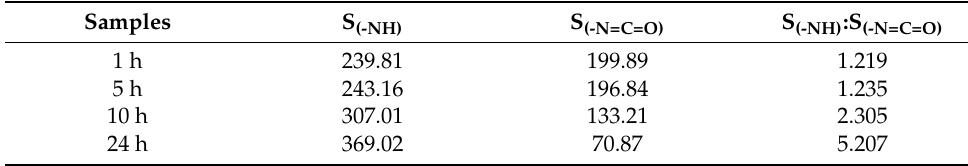
Figure 7. FT-IR spectra of emulsion with different standing time. Table 1. Integral area of carbamate groups (-NH) and isocyanate groups (-N=C=O) of emulsions with different standing time in FT-IR spectra.